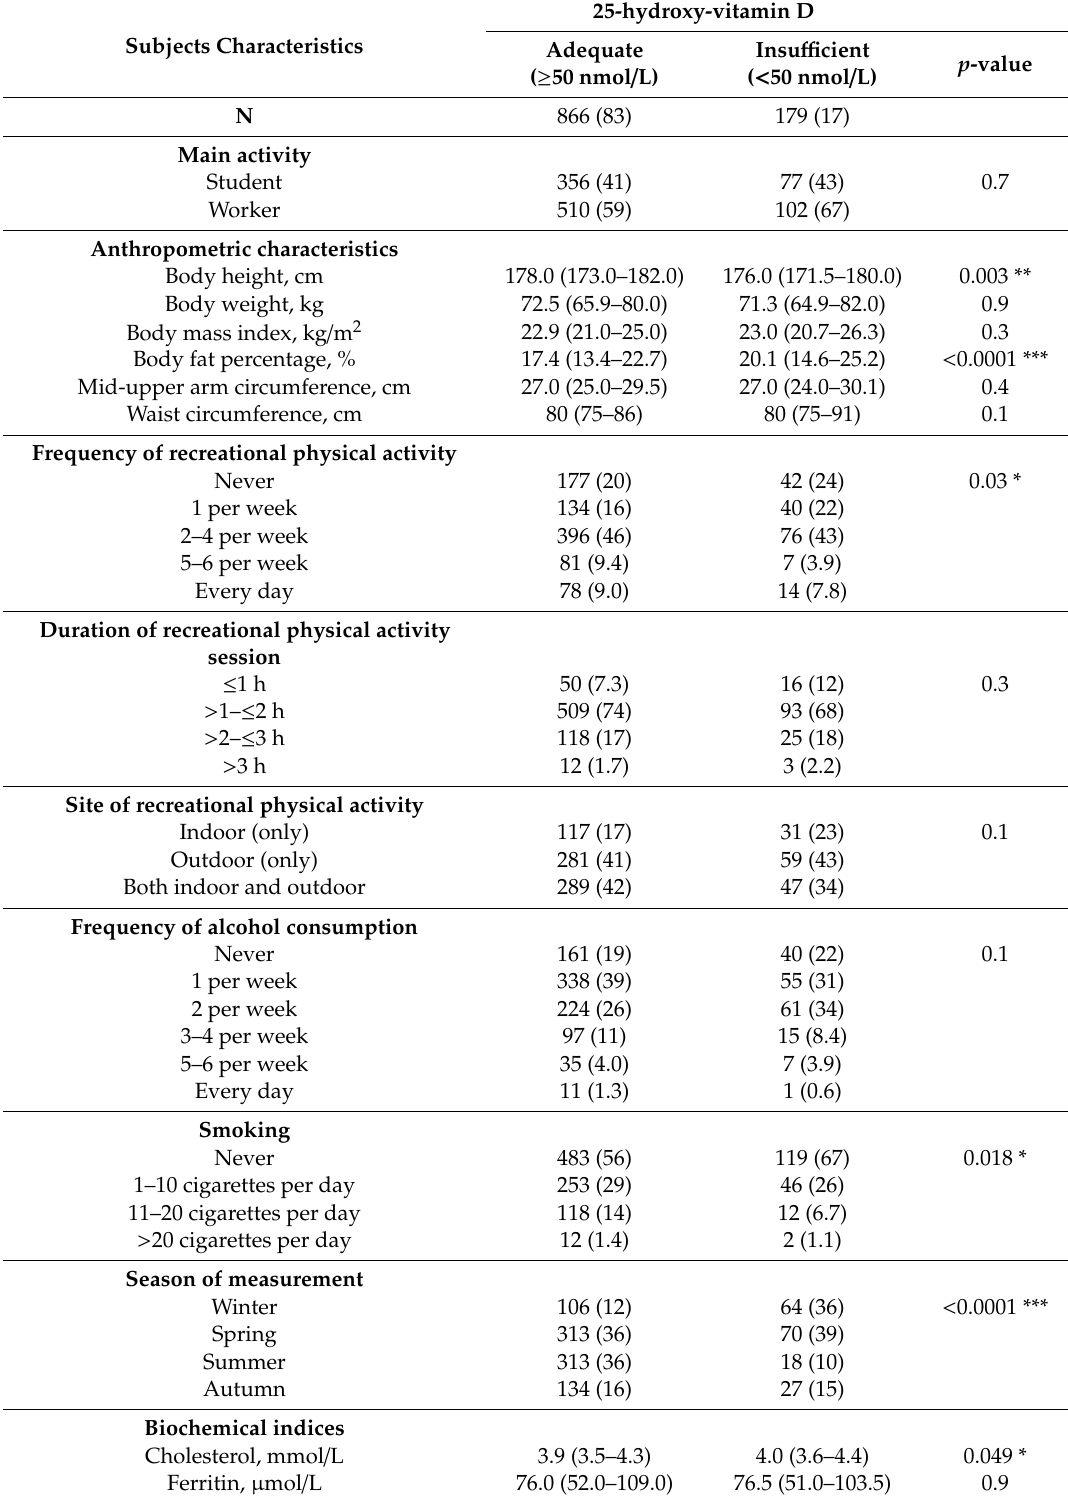
Table 2. Characteristics of subjects with adequate and insu ffi cient circulating 25-hydroxy-vitamin D. All variables were non-normally distributed. Data are given as absolute frequency (and percentage) or median (and interquartile range). The Kruskal-Wallis test was used for continuous variables. Chi-squared test was used for categorical variables. The Bonferroni test adjustment was applied to account for multiple